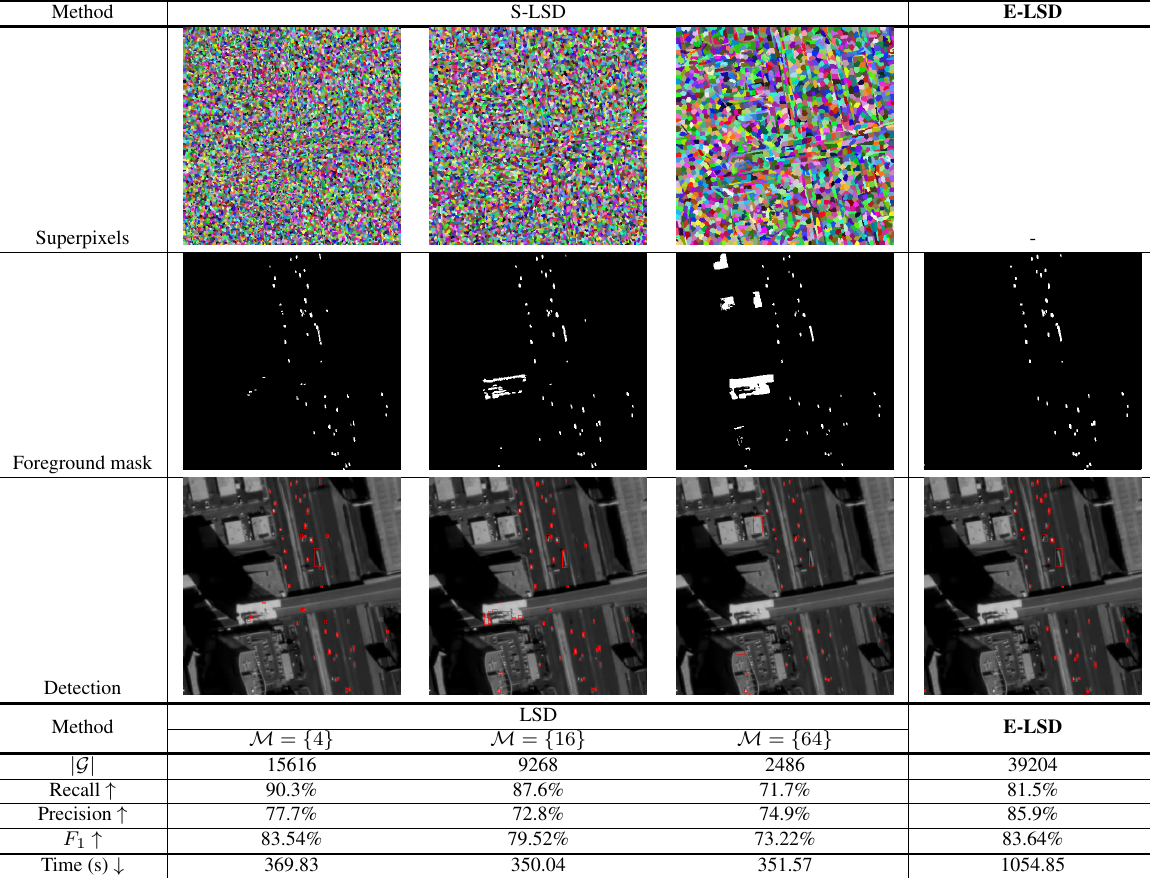
Figure 2. Demonstration on the effects of different scales in spatial regularization in S-LSD.